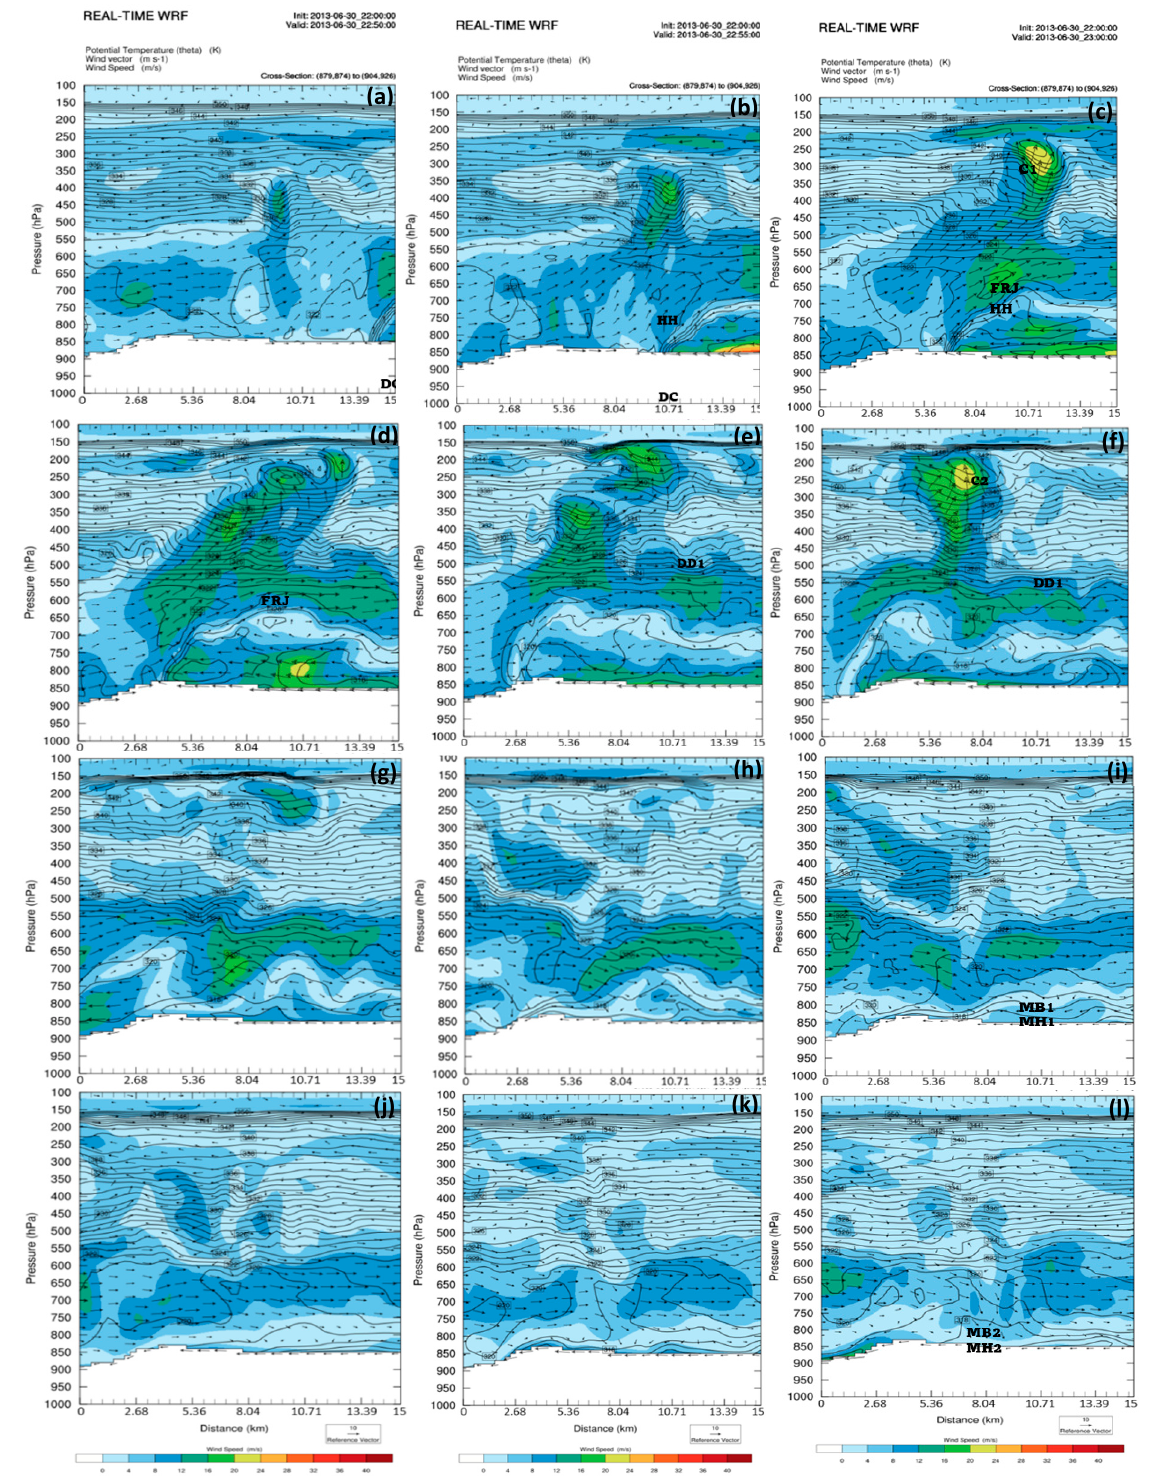
Figure 7. WRF-LES 259 m simulated vertical cross-section C-D of potential temperature (solid in K), 3D wind vectors (ms − 1 ), and isotachs (fill in ms − 1 ) within the plane of the cross-section valid at ( a ) 2250 UTC, ( b ) 2255 UTC, ( c ) 2300 UTC, ( d ) 2305 UTC, ( e ) 2310 UTC, ( f ) 2315 UTC, ( g ) 2320 UTC, ( h ) 2325 UTC, ( i ) 2330 UTC, ( j ) 2335 UTC, ( k ) 2340 UTC, and ( l ) 2345 UTC 30 June 2013. DC = density current, HH = hydraulic head, FRJ = front-to-rear jet, C = convective cell, MB = microburst, MH = meso- γ -scale high.